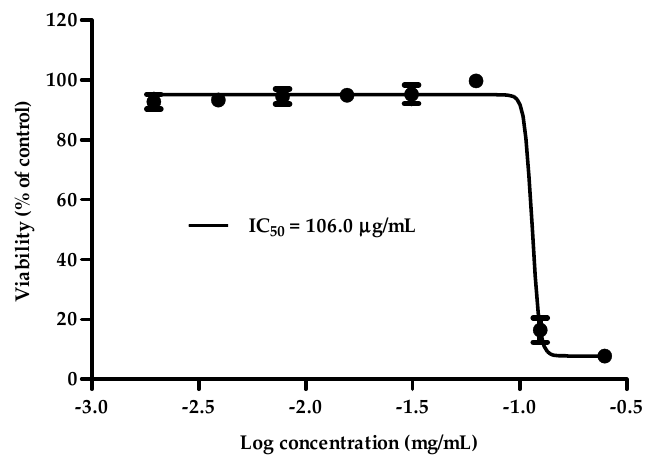
Figure 1. Cytotoxic e ff ects of the Cameroon (P-C) propolis extract at varying doses on phorbol 12-myristate 13-acetate (PMA)-di ff erentiated THP-1 cells. The P-C extract was cytotoxic to PMA-treated cells, with an IC50 of 106.0 µ g / mL. Each data point represents the mean ± SD ( n = 3). Table 1. Regions where propolis was collected and the concentrations of di ff erent propolis samples used on phorbol 12-myristate 13-acetate (PMA)-di ff erentiated THP-1 cells. Propolis Samples IC50 (µg/mL) Selected Final Concentration (µg/mL) Region